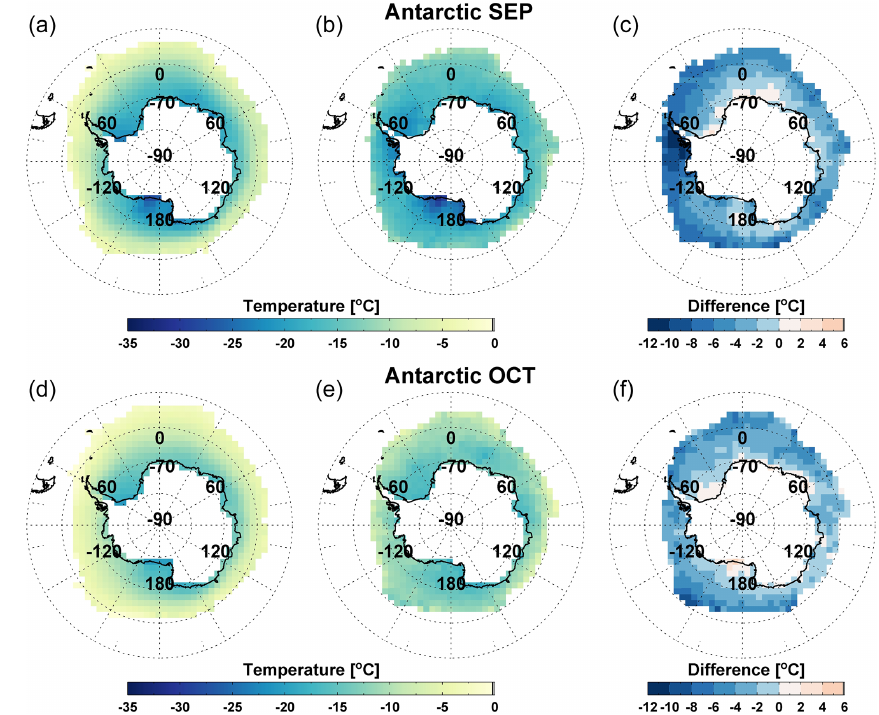
Figure 8. As Fig. 7 but for the Antarctic in September (a–c) and October (d–f)